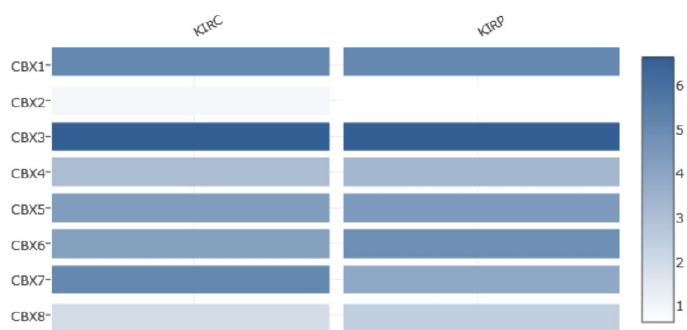
Figure 2. This feature provides expression matrix plots based on CBX genes. The density of color in each block represents the median expression value of a gene in a given tissue, normalized by the maximum median expression value across all blocks. Analyses were performed using GEPIA2 * p < 0.05. Abbreviations: KIRC: kidney renal clear cell carcinoma, KIRP: kidney renal papillary carcinoma.